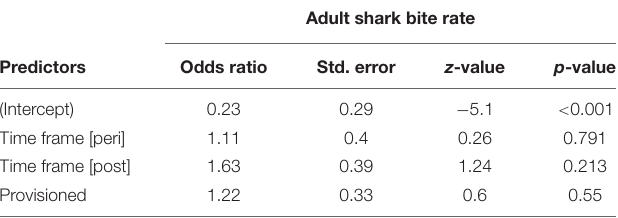
Statistically significant values are indicated in bold. TABLE 4 | Annual probability of receiving a shark bite wound for non-provisioned and provisioned seagrass specialists before, during, and after the MHW.